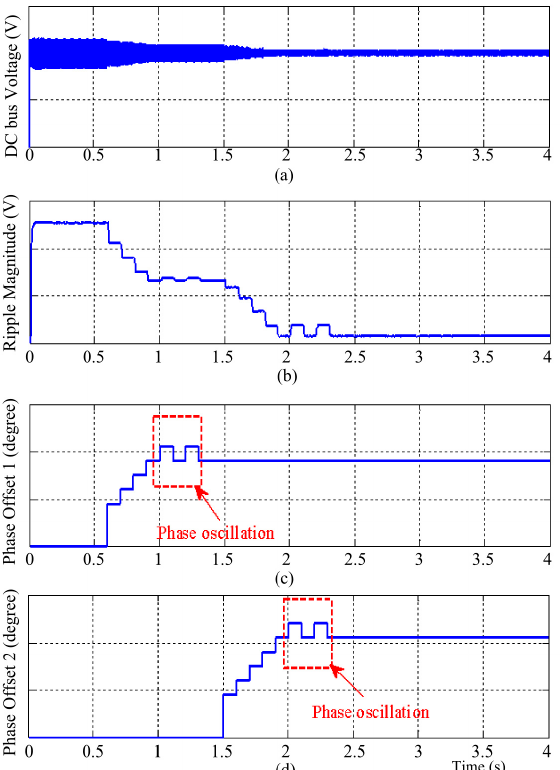
Figure 13. (Case 2) simulation results for unequal load sharing. ( a ) DC bus Voltage; ( b ) Ripple Magnitude; ( c ) Converter 2 phase-offset; ( d ) Converter 3 phase-offset.